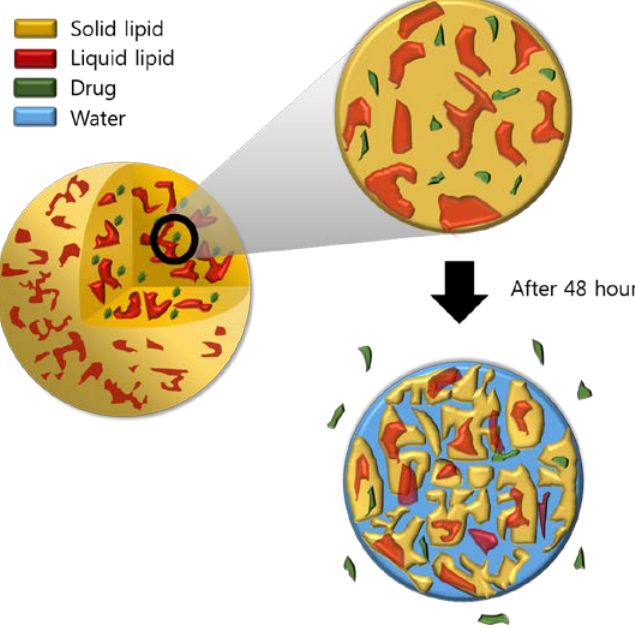
Figure 13. NLC model showing the release of PR.